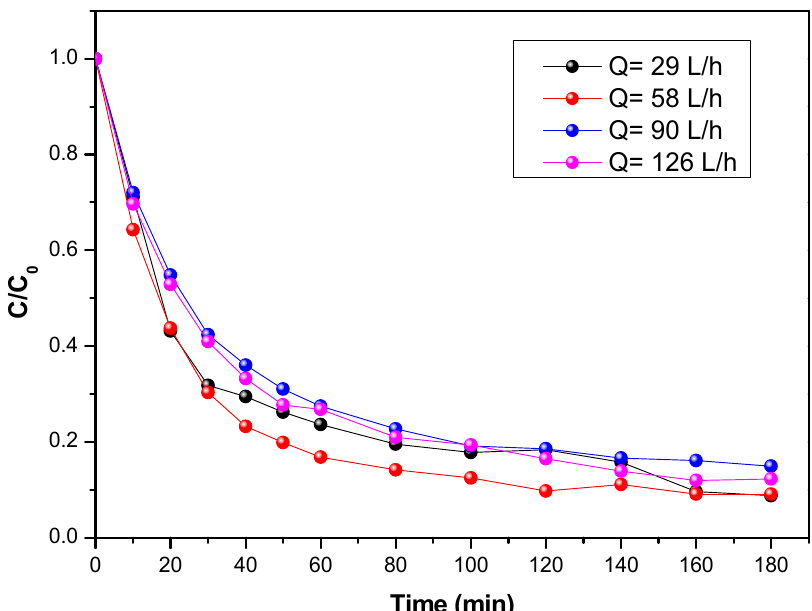
Figure 4. Evolution of the concentration of flumequine during its photocatalytic degradation for four flow rates at an initial concentration of 5 mg/L and a UV of 38 W/m 2 .